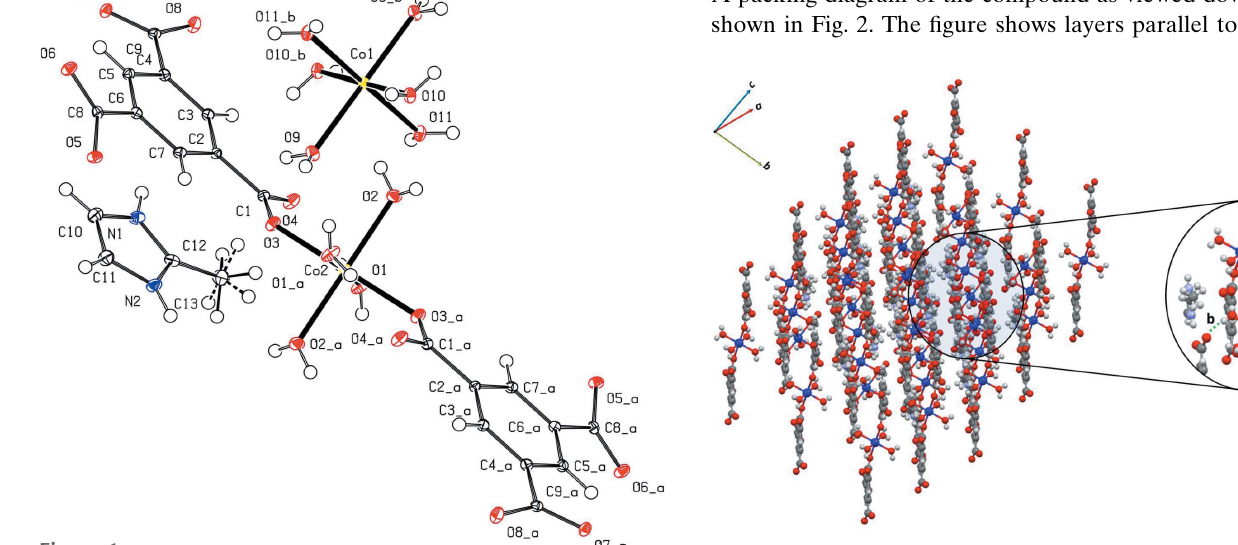
Figure 2 Packing diagram of 1 down the [101] direction. O—H (cid:5)(cid:5)(cid:5) O hydrogen bonds of type b , c and i are shown in the magnified region.